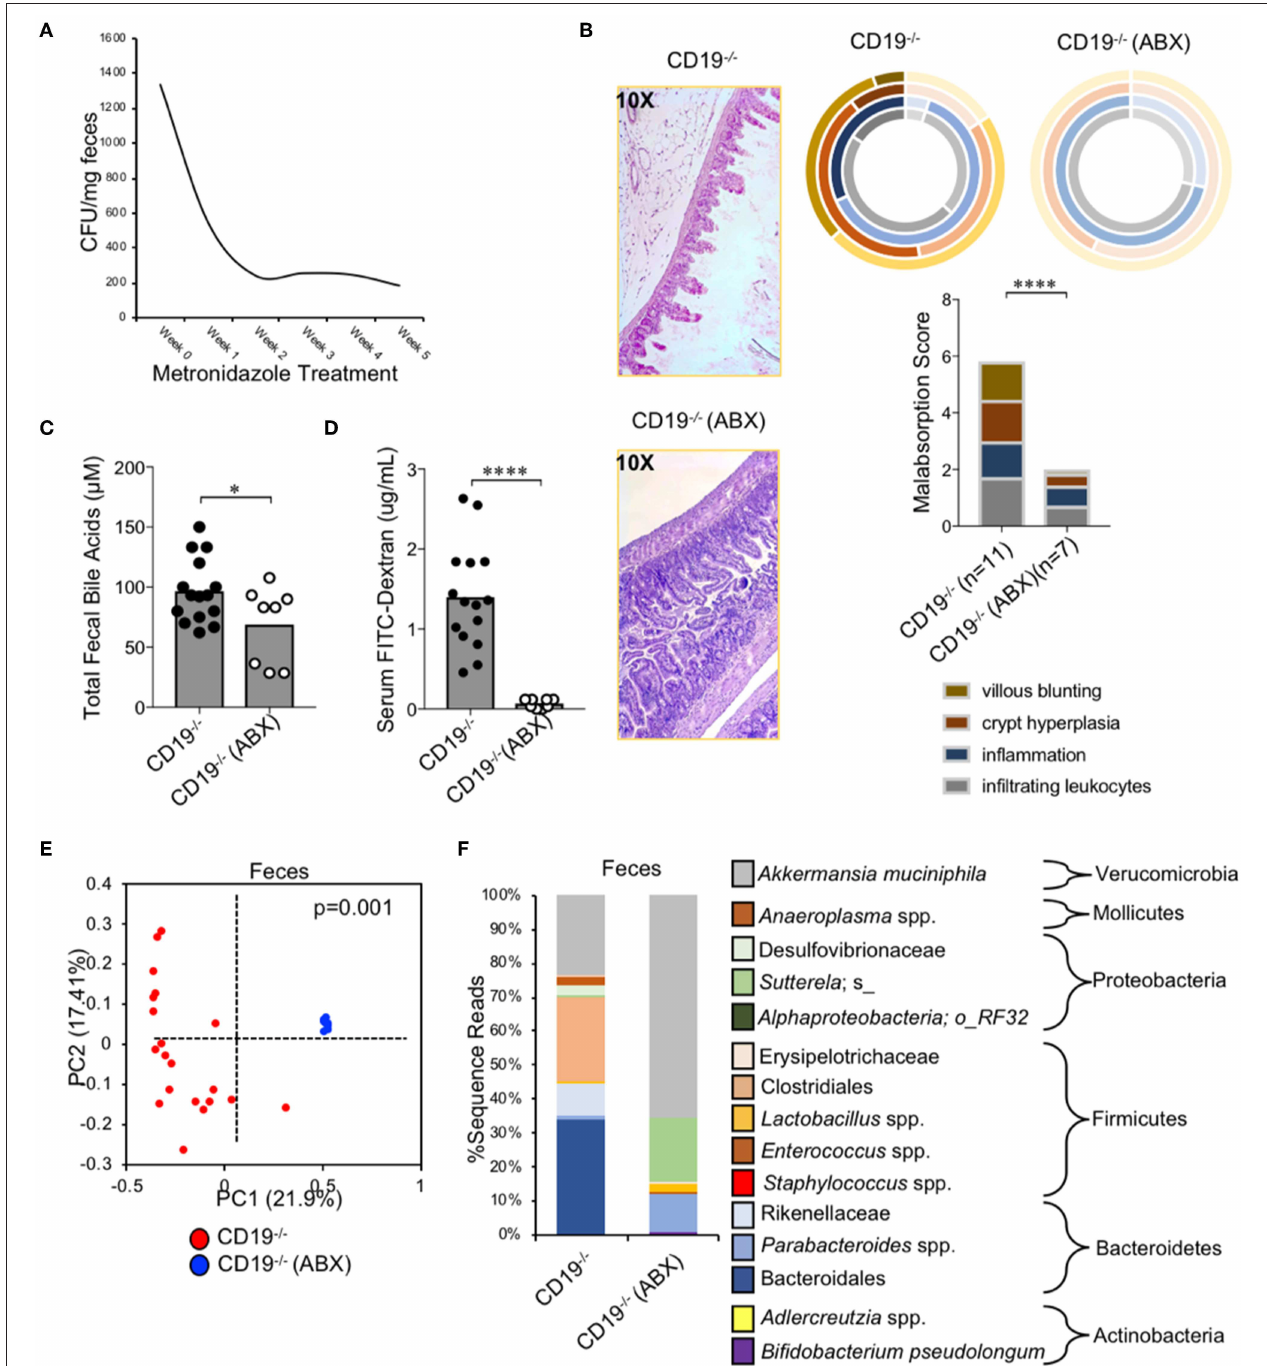
FIGURE 6 | Malabsorption in CD19 − / − mice is microbiota-dependent. (A) Fecal anaerobic bacteria abundance during 5 week metronidazole exposure. (B) Malabsorption scoring for ABX-treated CD19 − / − mice compared to untreated controls. (C) Total fecal BA quantification of ABX-treated mice vs. controls is shown. (D) Serum FITC-Dextran concentrations of ABX-treated mice vs. controls is shown. (E) PcoA plot based on unweighted UniFrac analysis of β -diversity between fecal microbial communities from ABX-treated CD19 − / − mice compared to untreated controls. (F) Stacked barplot summarizing bacterial groups whose abundance significantly changes in ABX-treated mice compared to controls. (C,D) Student’s t -test; * = p < 0.05, **** = p < 0.0001. (E) P -value represents result of PERMANOVA testing with 999 permutations. (F) Significant groups of differentially enriched bacteria were identified with discrete FDR testing. (B) Result of Two-way ANOVA (row factor = genotype), **** = p <